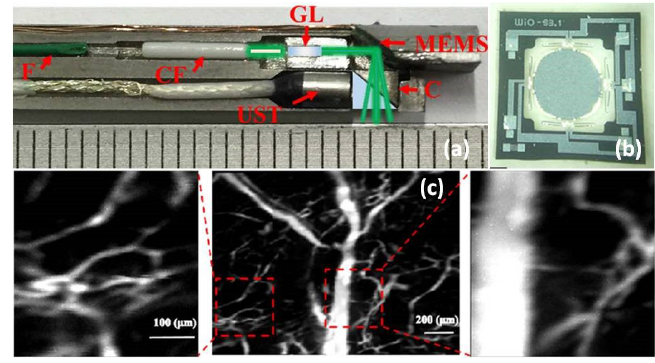
Figure 7. MEMS-based photoacoustic (PA) microendoscope. ( a ) Photograph of the assembled imaging probe. ( b ) Photograph of the electrothermal MEMS mirror. F: fiber; CF: ceramic ferrule; GL: GRIN lens; MEMS mirror; UST, ultrasound transducer; C, cube. ( c ) High-resolution photoacoustic imaging of a mouse ear, the MAP image (left) was acquired with 20 sub images and two typical subimage (right) indicated by the dashed rectangle. Reproduced with permission from [44]; published by OSA, 2017.